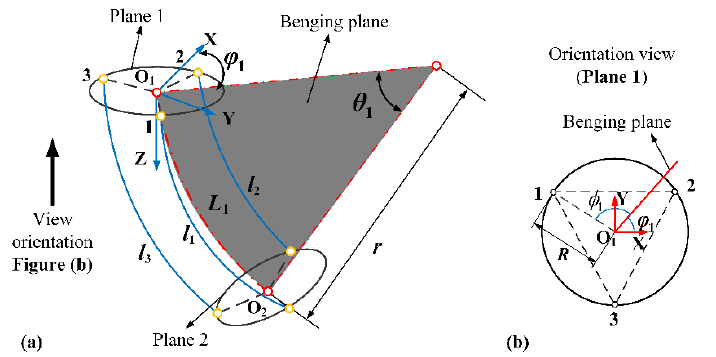
Figure 4. Mapping between the driving space and the joint space of the distal segment. ( a ) Bending configuration of the distal segment. ( b ) Positional layout of the actuation cables.